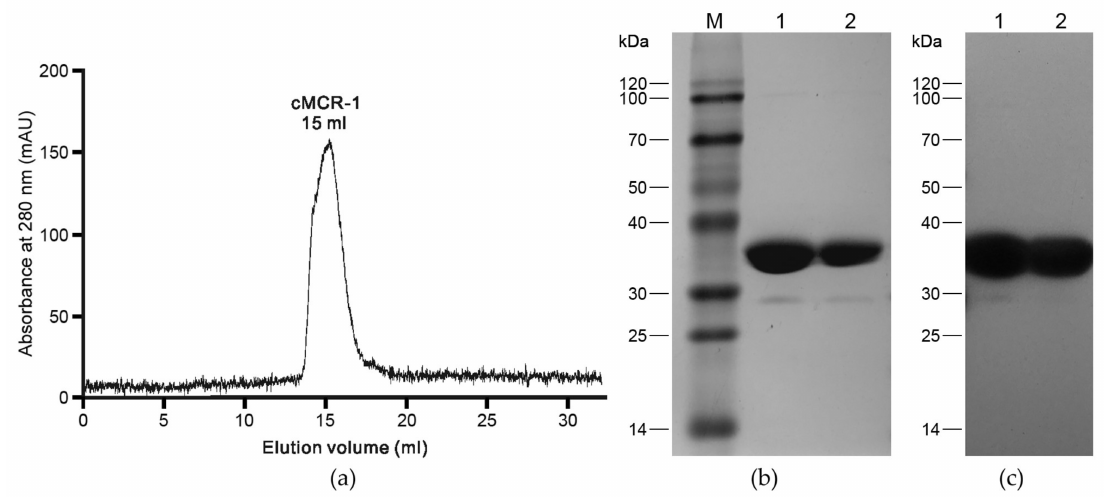
Figure 1. Purification and purity analysis of cMCR-1. ( a ) Gel filtration chromatography of cMCR-1. ( b ) SDS-PAGE of the final purified cMCR-1 and cMCR-1 crystals. Molecular-weight markers (lane M, labelled in kDa), purified ~35 kDa cMCR-1 protein (lane 1) and cMCR-1 crystals (lane 2) are shown. ( c ) Western blot analysis of the final purified cMCR-1 and cMCR-1 crystals using an anti-6 × His antibody.